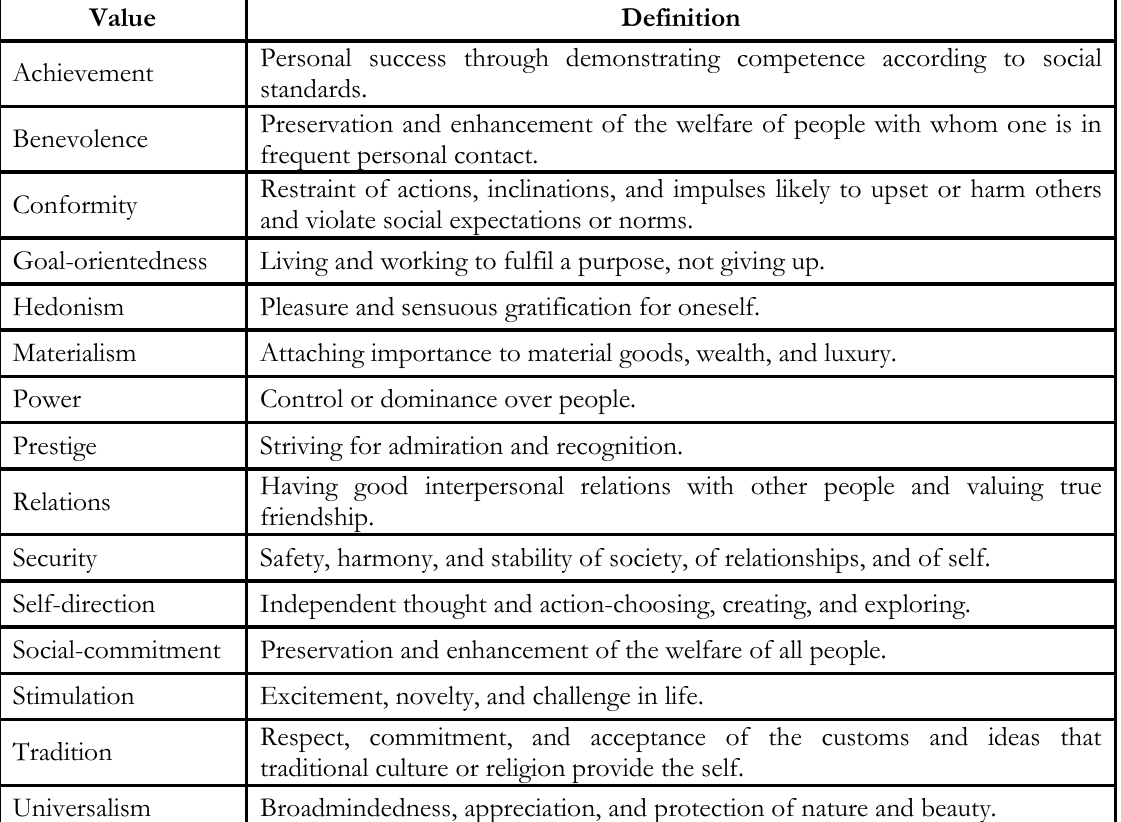
Table 1: Definitions of 15 motivational types of values in terms of their goals Value Definition